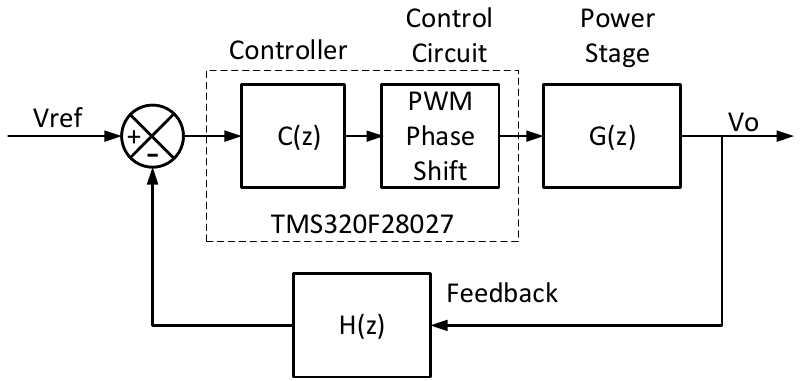
Figure 11. Digital Feedback system block diagram.